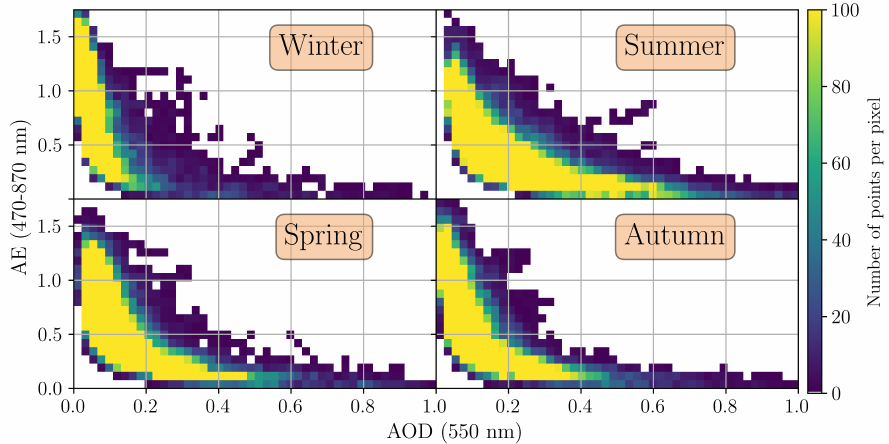
Figure A2. Density number plot between MERRA-2 AOD and AE (2002–2020) per season over